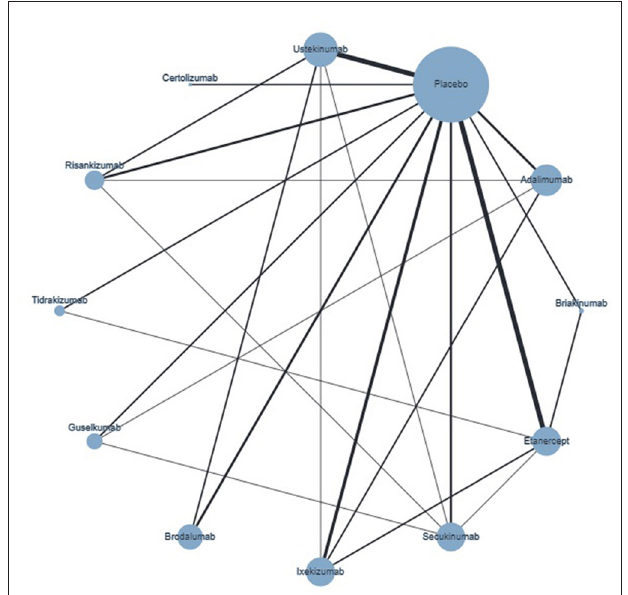
FIGURE 4 | Network plot of PASI100 showing direct comparisons, at weeks 10–16. The width of the edge is proportional to the number of studies, and the node size is proportional to the sample